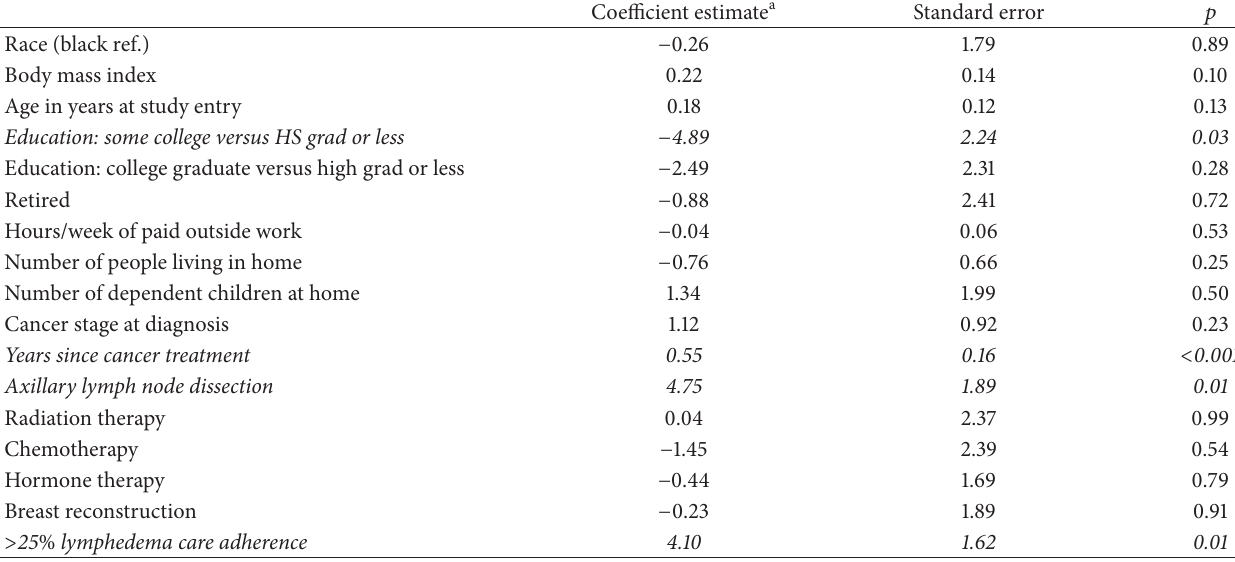
Table 2: Multivariable linear regression for interlimb volume difference